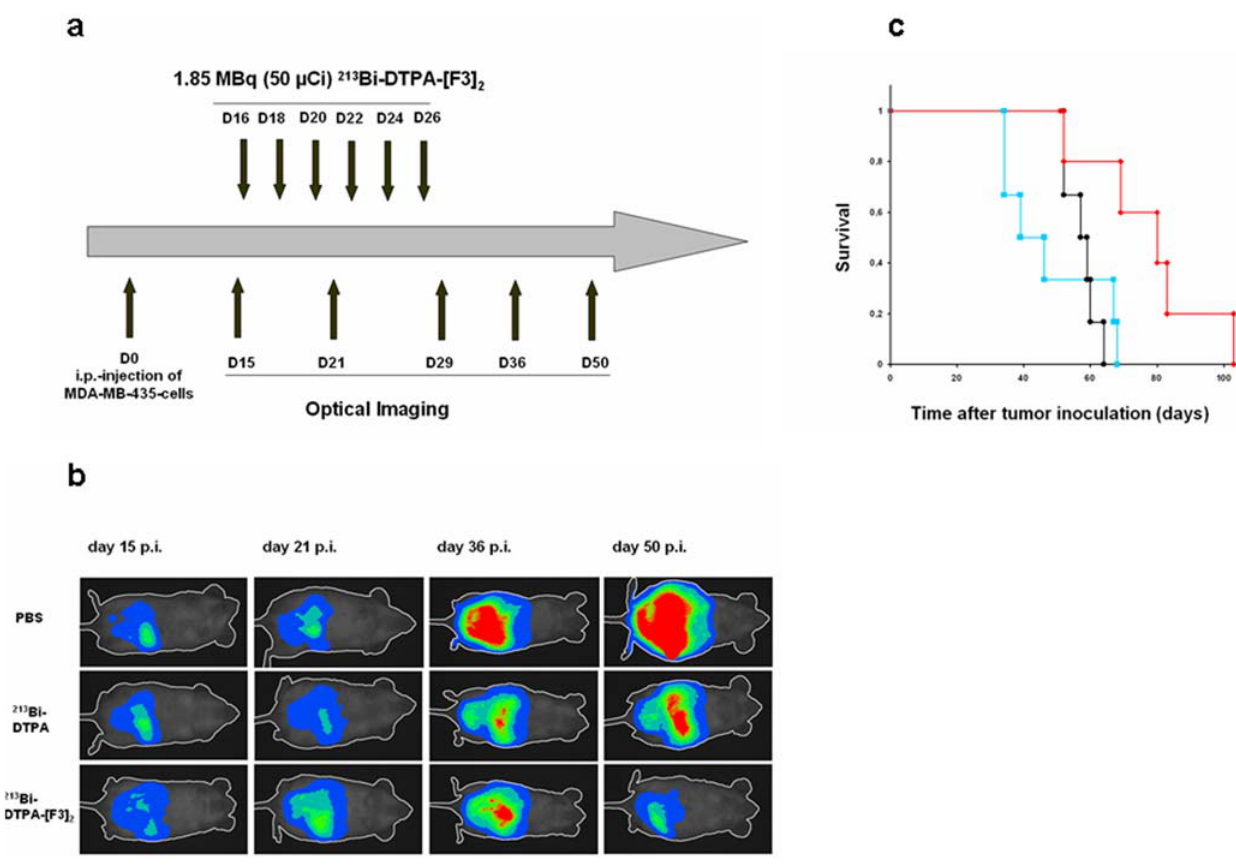
Figure 5. Tumor reduction study. (a) The scheme depicts the time points when 213 Bi-DTPA-[F3] 2 was injected and the time points when optical imaging was performed. (b) Assessment of the tumor growth by optical imaging in mice treated with 213 Bi-DTPA-[F3] 2 or in control mice treated with PBS or 213 Bi-DTPA. (c) Kaplan-Meier analysis of the survival of mice with intra-peritoneal tumors treated with 213 Bi-DTPA-[F3] 2 (red), 213 Bi-DTPA (green) or PBS